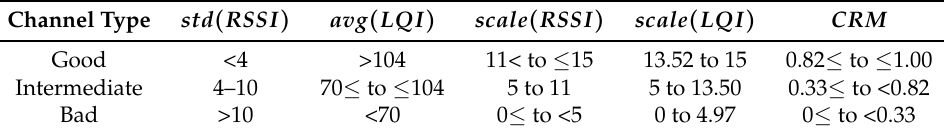
Table 3. Channel rank measurement